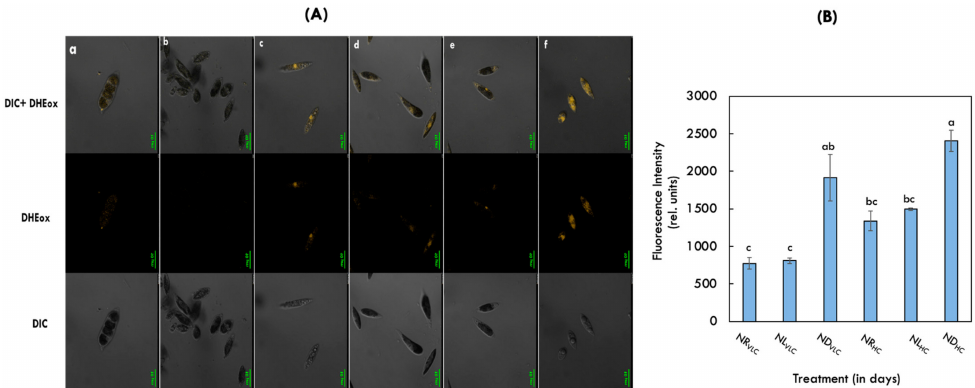
Figure 3. ( A ) Imaging of the Superoxide anion radical activity in the native isolate Monoraphidium sp. CABeR41 on the 10th day of cultivation by laser confocal scanning microscopy with an excitation wavelength of 520 nm and emission wavelength of 570 nm subjected to ( a ) NR VLC ; ( b ) NL VLC ; ( c ) ND VLC ; ( d ) NR HC ; ( e ) NL HC ; ( f ) ND HC conditions using DHE staining. ( B ) Relative fluorescence intensity of the DHE stained cells on the 10th day of cultivation in the NR VLC , NL VLC , ND VLC , NR HC , NL HC , and ND HC conditions. Values indicated are mean average ( n = 3) ± S.E.; different lowercase letters indicate the statistical significance by two-way ANOVA with p -value < 0.05 using post hoc analysis by Tukey’s honestly significant difference